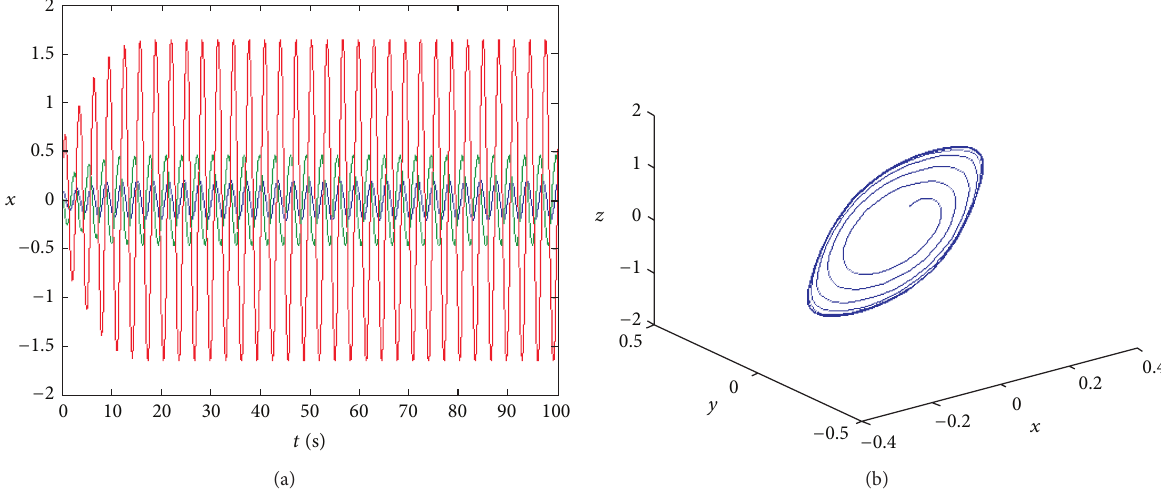
Figure 5: Time history and phase diagram of system (3) with 𝑎 = −1 , 𝑏 = 1 , 𝑐 = −1 , 𝑒 = 18 , and 𝑑 = −0.8